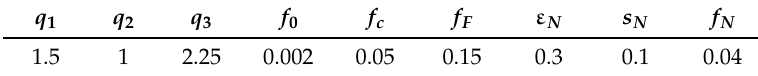
Table 2. Setup for the simulation parameters.